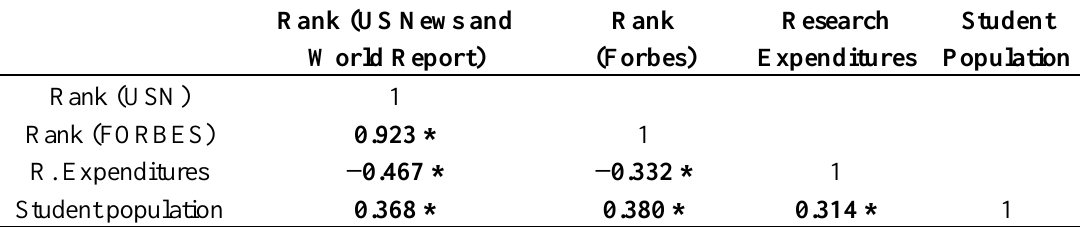
Table 2. Correlation between institutional